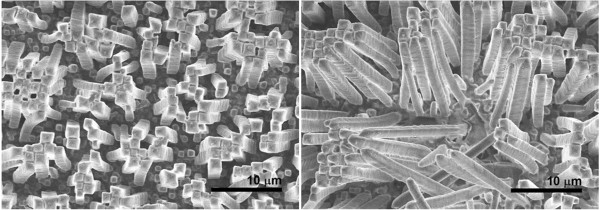
ESEM images of PMMA microcolumns with embedded (Er,Yb):Lu2O3 nanocrystals.